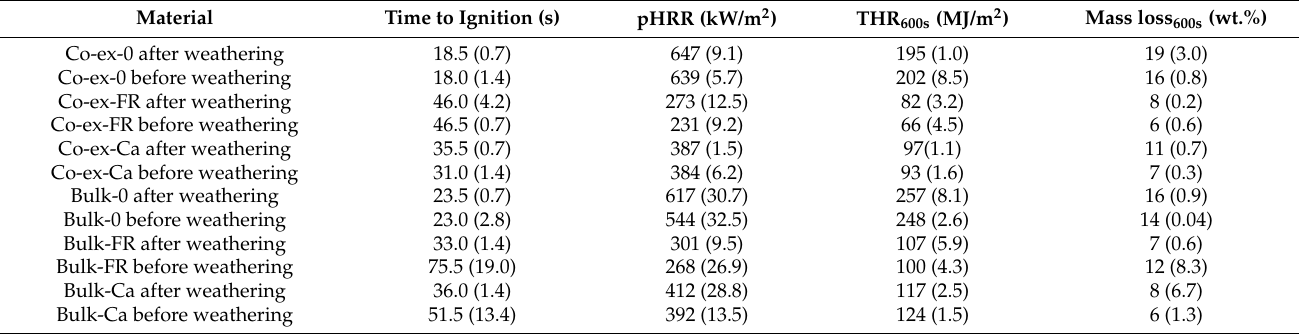
Table 12. Fire properties of solid profiles before and after artificial weathering (28 days) obtained using a cone calorimeter with 50 kW/m 2 irradiation. The fire-retardant or CaCO 3 were present either in the co-extruded layer only or in the bulk of the profile. For composition of formulations, see Material and Methods. Values represent the average of two samples with standard deviation in